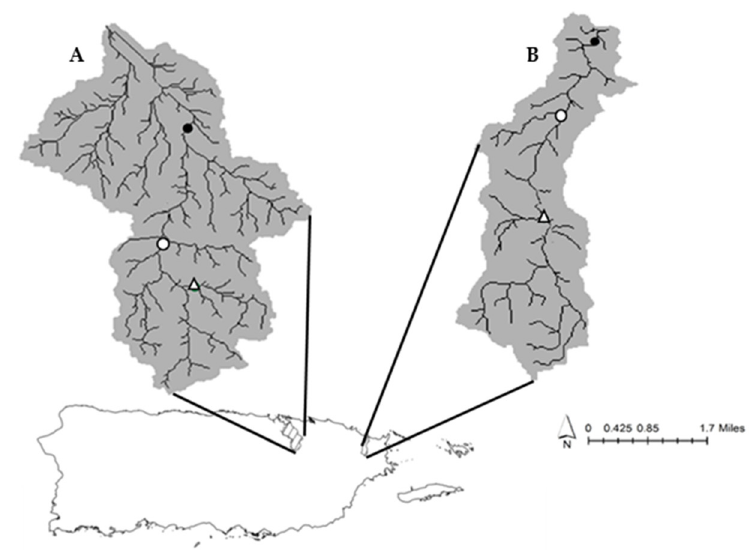
Figure 1. ( A ) Urban watershed (Río Piedras), ( B ) forested watershed (Río Sabana). The white triangle represents low urban reach (LU), the white circle represents medium urban reach (MU), and the black circle represents high urban reach (HU).